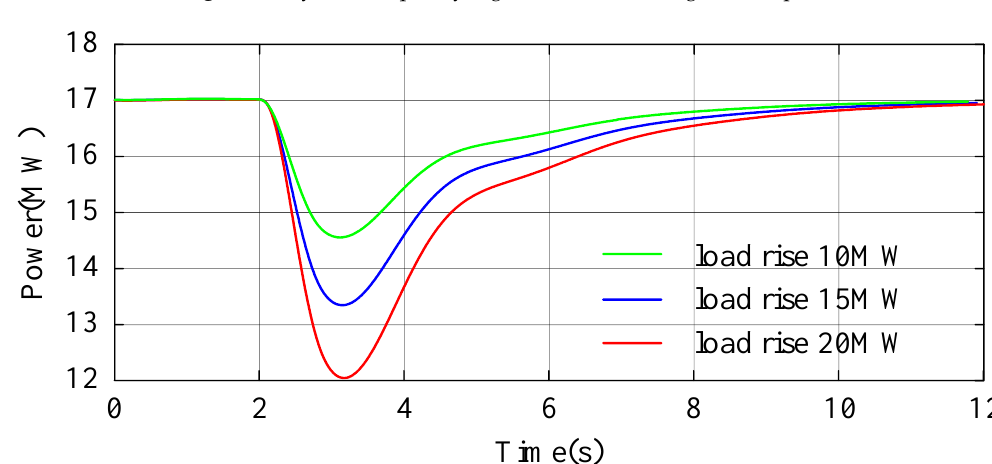
Figure 24. Operation curve of P2H at high wind speed.